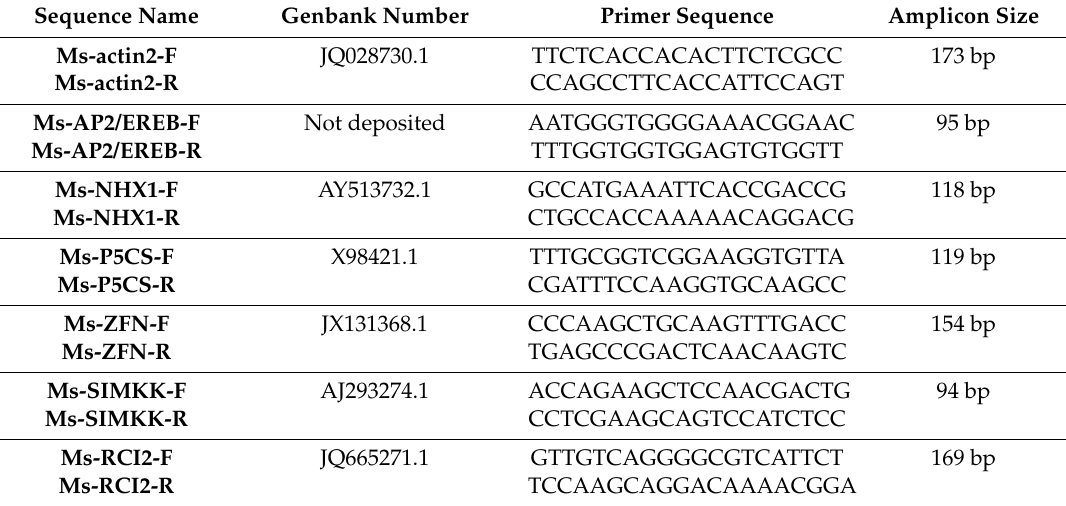
Table 1. The real-time PCR primers of Msactin2, MsRCI2A, MsNHX1, MsAP2/EREB,